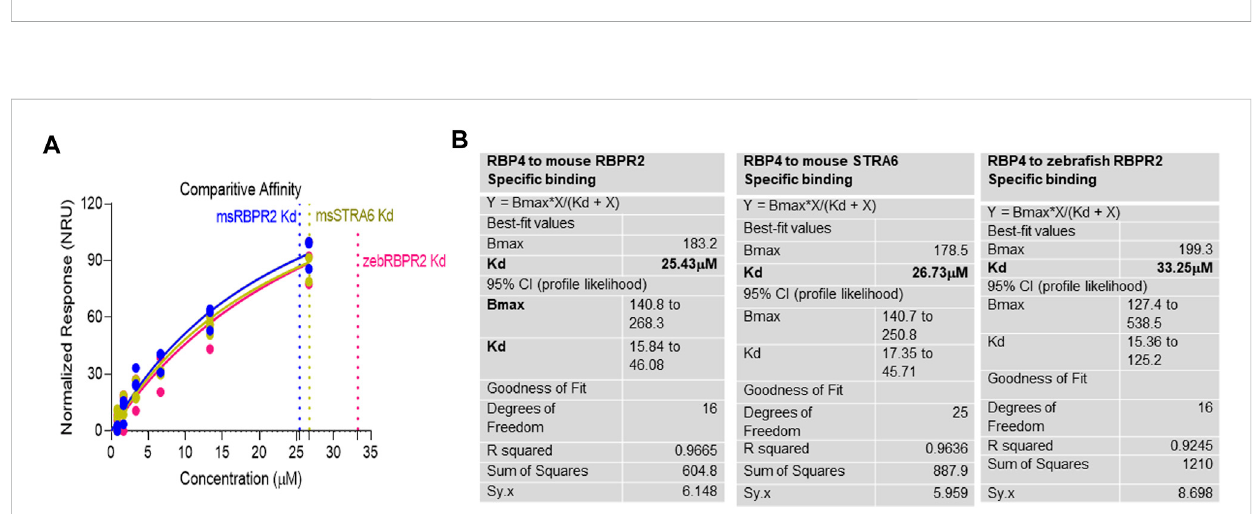
Kinetics of surface plasmon resonance binding studies between RBPR2 and its ligand RBP4. (A,B) Detailed SPR kinetics shown for mouse and zebra fi sh RBPR2 and for mouse STRA6 with its immobilized ligand mouse RBP4 protein. The af fi nity K d values are shown in bold.